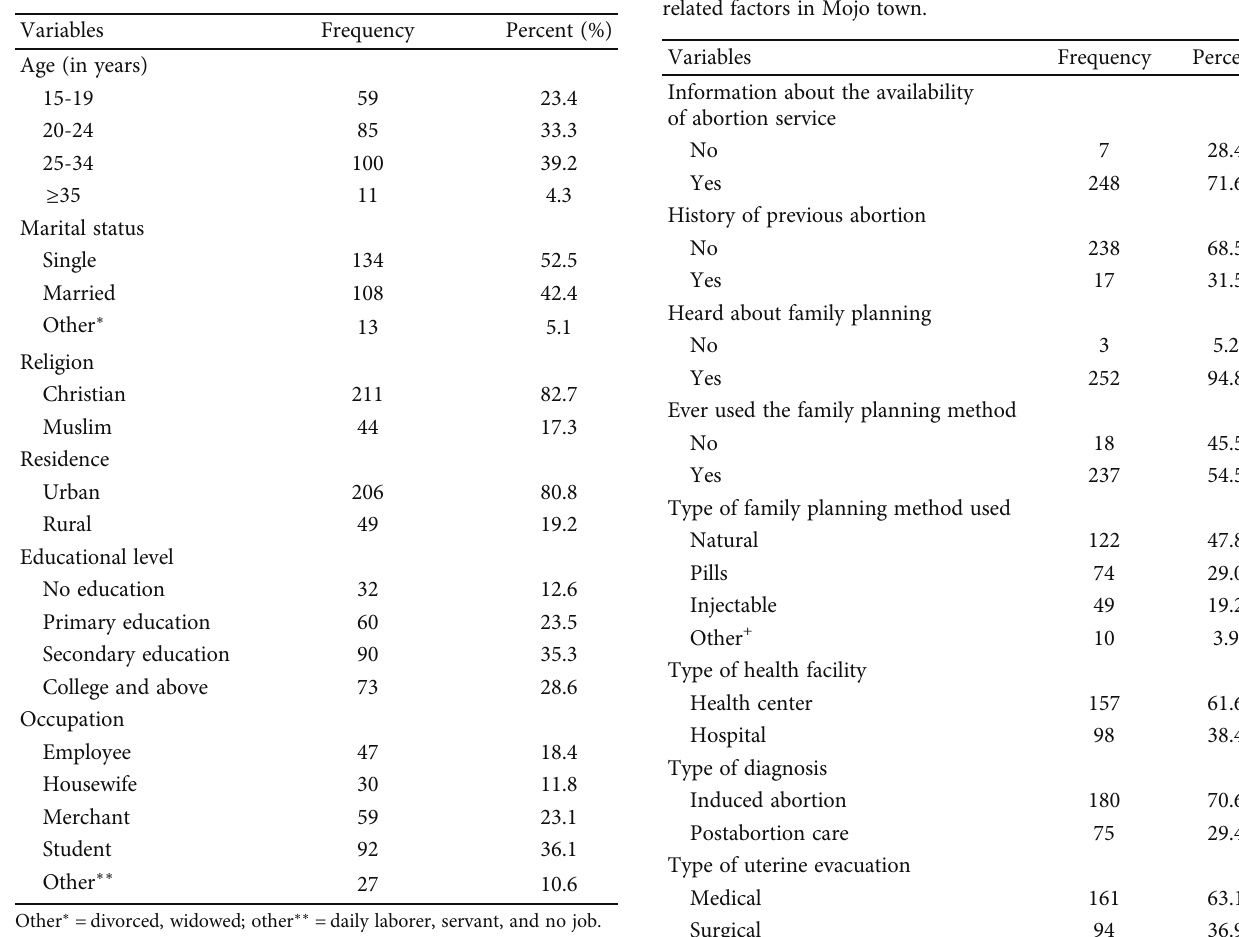
Table 1: Sociodemographic characteristics of participants receiving abortion care in public health facilities of Mojo